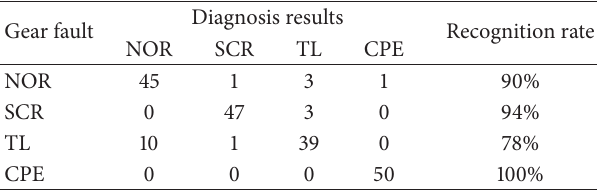
Table 5: Classification results with proposed method (DFA5). Gear fault